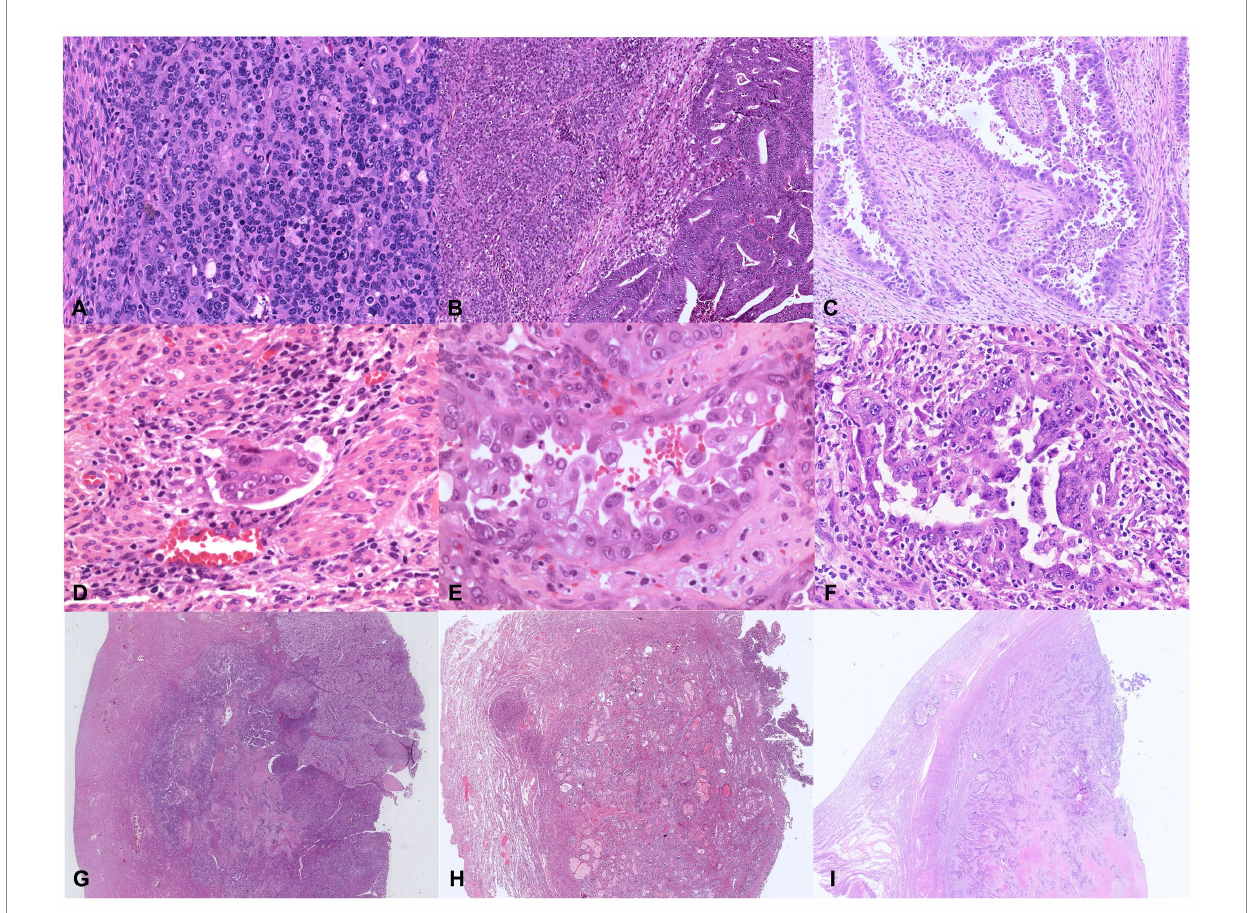
FIGURE 6 Illustrative histologic pictures of the four histopathologic parameters of the proposed algorithm of different molecular subgroups: (A) Undifferentiated POLE -mutant EC (Hematoxylin and Eosin; x100 magnification); (B) Dedifferentiated MMRd EC (Hematoxylin and Eosin; x100